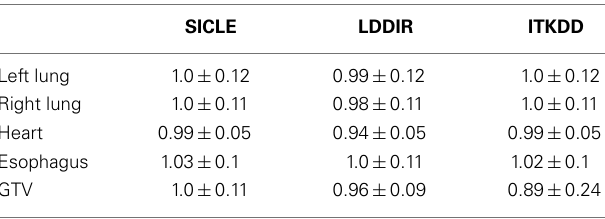
Table 1 | Ratio of average Jacobian to actual volume change